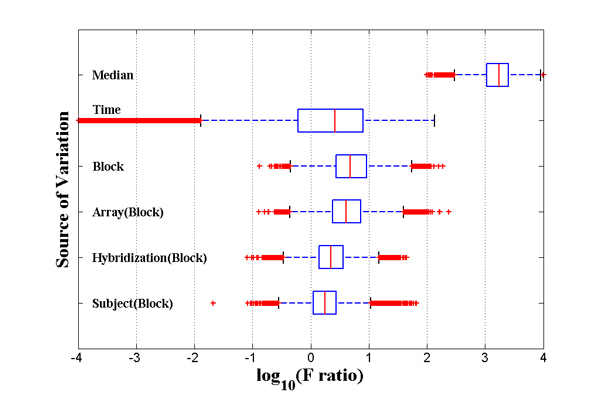
Box plots summarizing the logarithm of F-ratios computed in the 32,112 analyses of covariance. The F-ratios for six sources of variation are each represented by a box plot. The box encloses the range between the first and third quartile. The interior line is the median (Table 1). The dashed blue line encloses the interior 95% of the observations. More extreme values are plotted with a plus (+) symbol; a few values for 'Time' less than -4 and values for 'Median' greater than 4 are not shown.